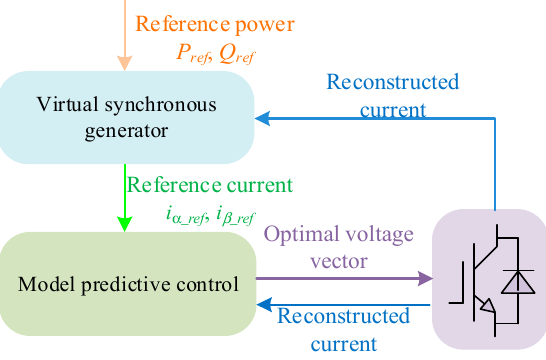
Figure 7. The connection among VSG, MPC, and current reconstruction.